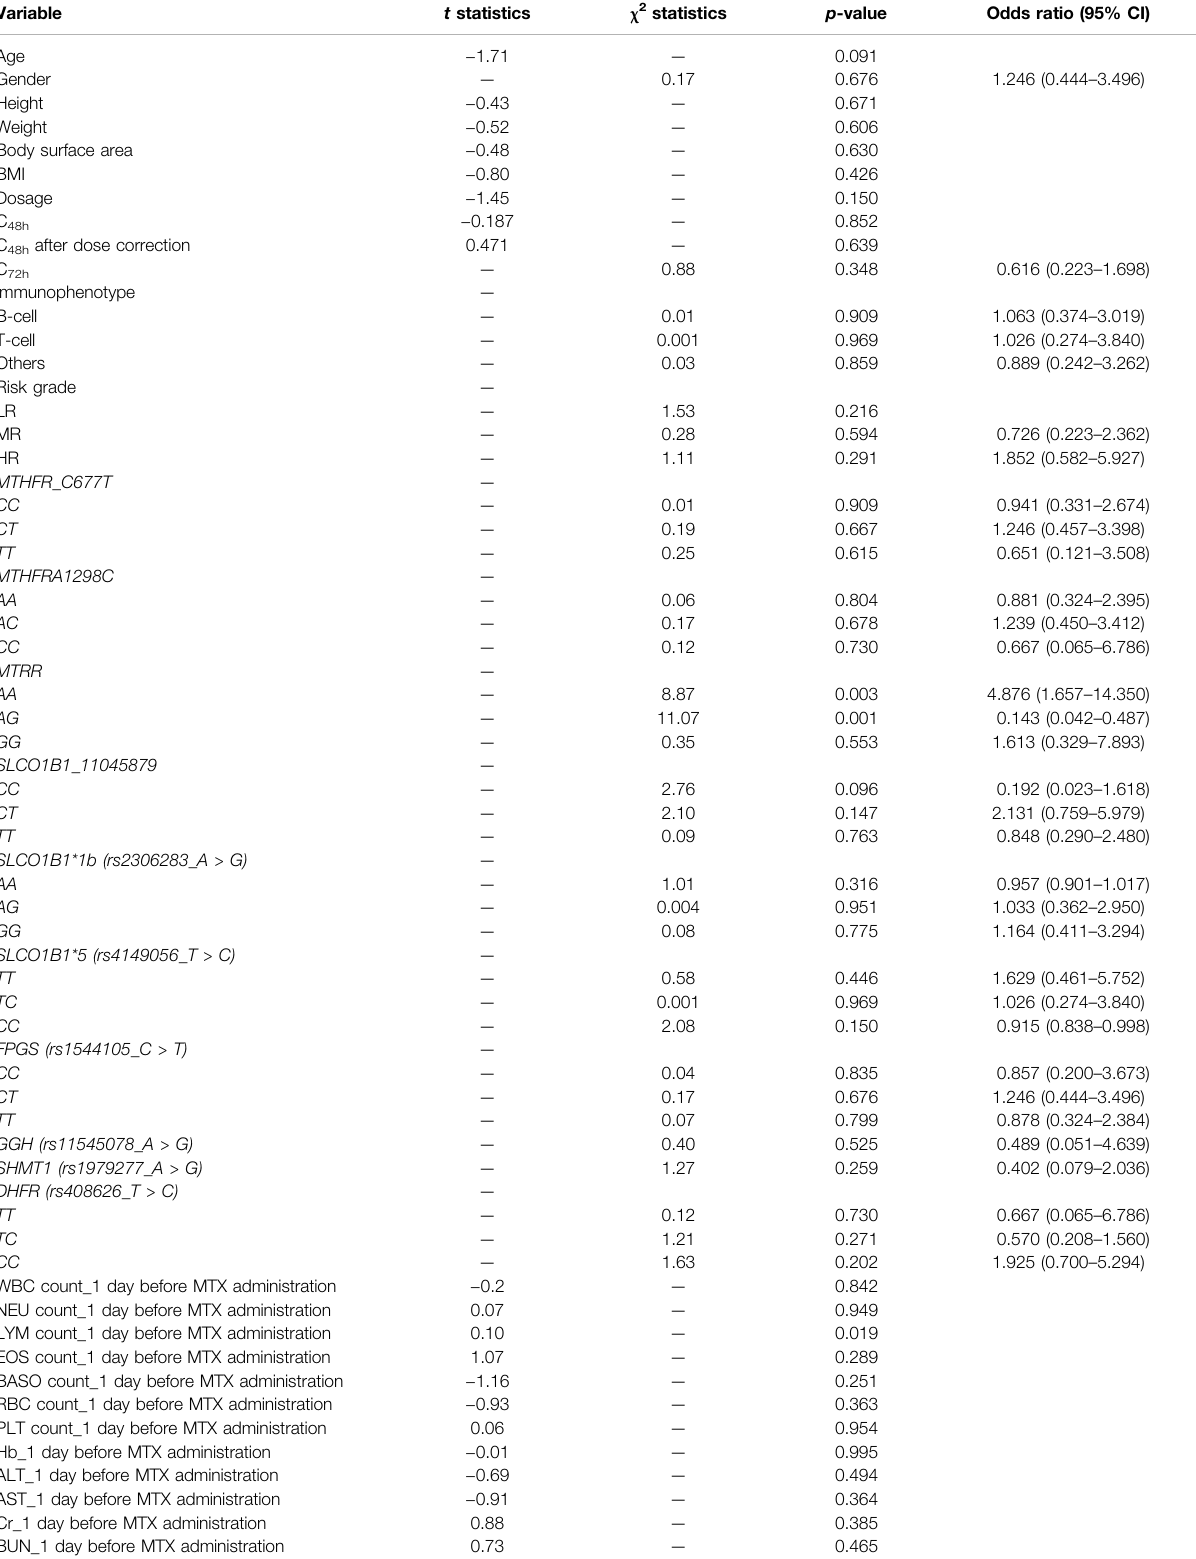
TABLE 3 | Signi fi cance analysis of the in fl uencing variables of liver injury.